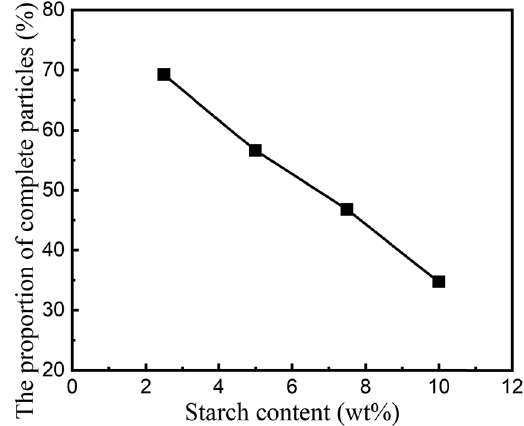
Figure 6: E ff ect of starch content on the complete particles in frac - ture